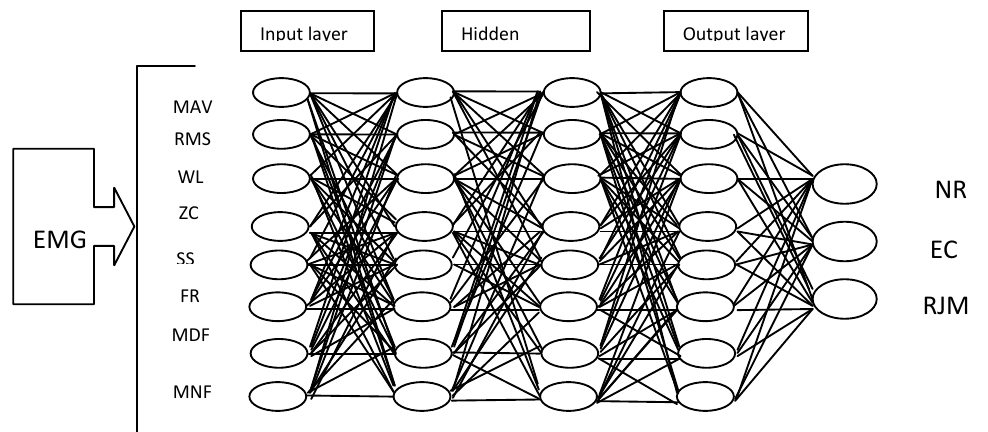
Figure 9. Schematic diagram of back propagation artificial neural networks (BPANN) with Levenberg-Marquardt algorithm [101].